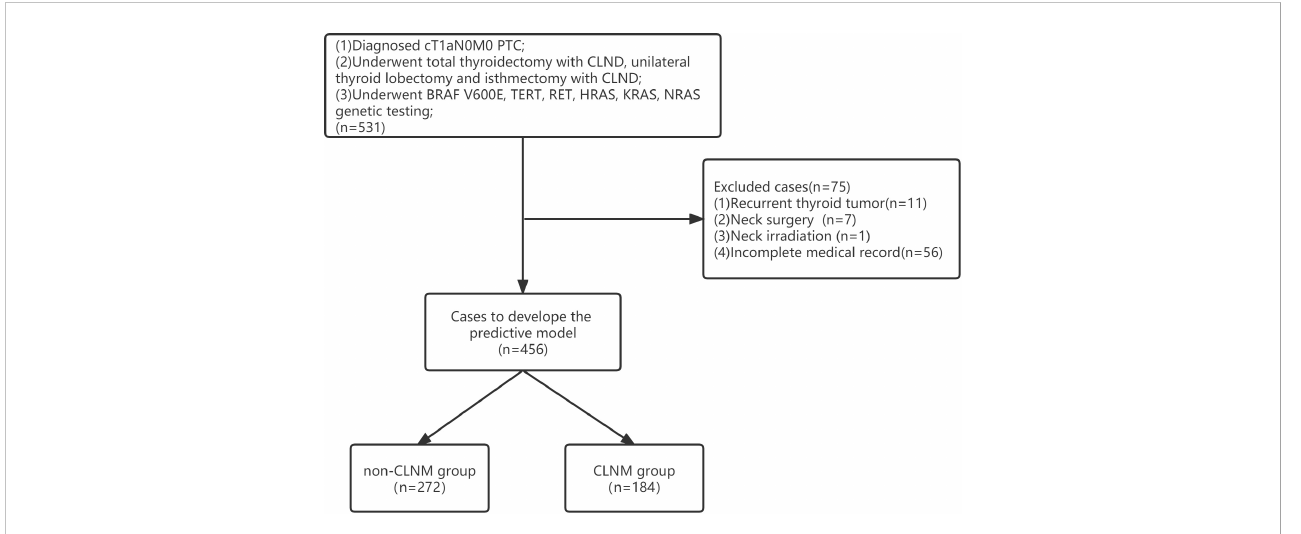
FIGURE 1 Flow chart for patient